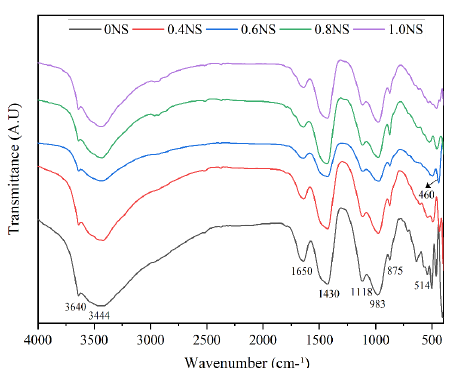
Figure 8. FTIR transmission spectra of cement pastes produced with NS at 28 days.